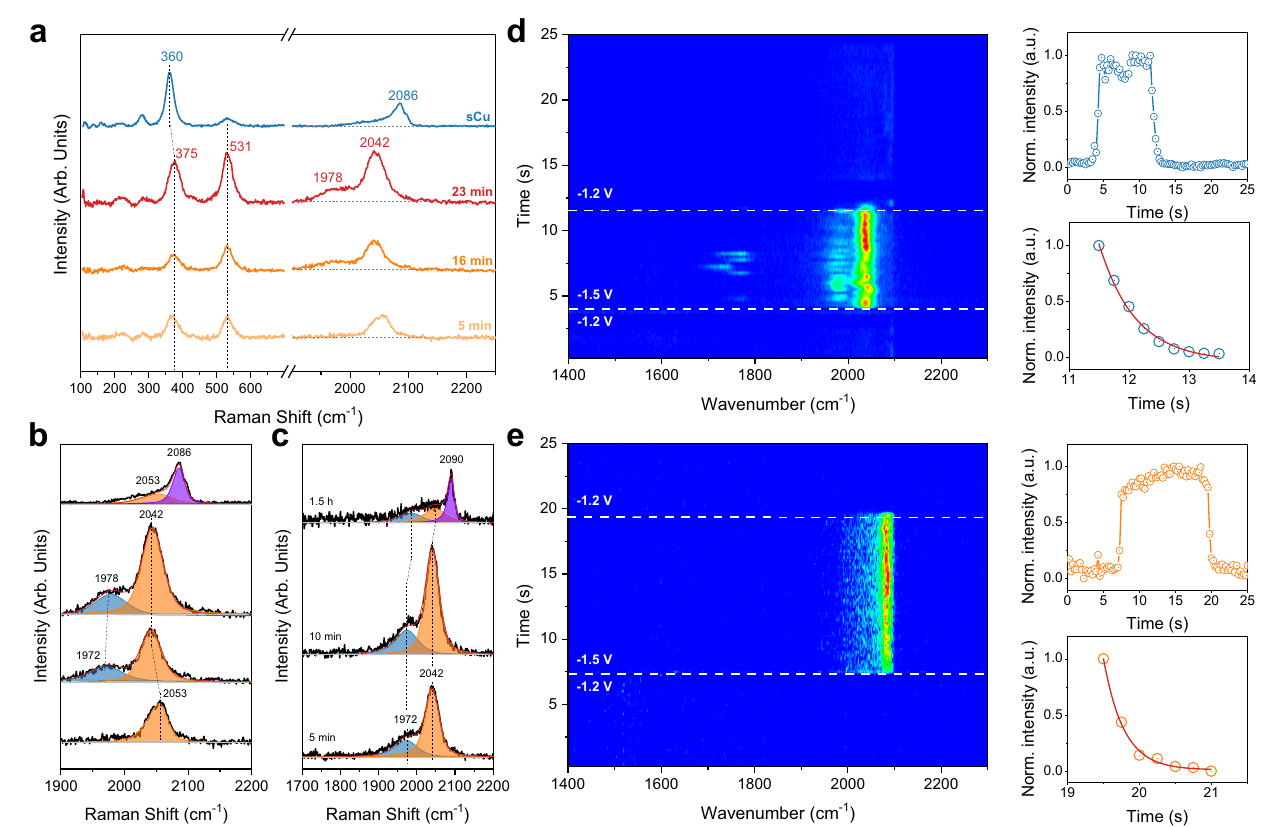
Fig.3|InsituRamanspectroscopyofsCuandEC – Cucatalysts.a Ramanspectra ofsCuand EC – Cuafterdifferentelectrodepositiontime. b Deconvolved spectraof the ν (CO atop )regionof( a ). c Deconvolvedspectraofthe ν (CO atop )regionforEC – Cu catalyst after 5, 10, and 90min of CO 2 electrolysis. d Time-resolved in situ Raman spectra of EC – Cu under − 1.2 and − 1.5V applied potentials. The top right panel summarizes the normalized intensity of the 2042cm − 1 peak as a function of time. The bottom right panel illustrates the time-dependent change of the normalized intensity for the 2042cm − 1 peak after a potential step to − 1.2V.The red curve is an